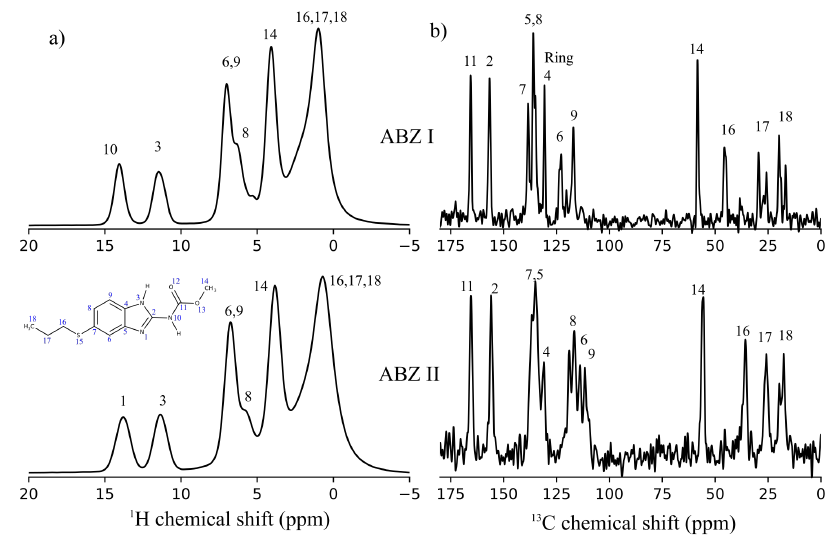
Figure 4. ( a ) 1 H ; and ( b ) 13 C MAS-ssNMR spectra of ABZ I and ABZ II. The spectra are recorded at a field of 11.7 T with the MAS spinning of 57.143 kHz at a temperature of 320 K.